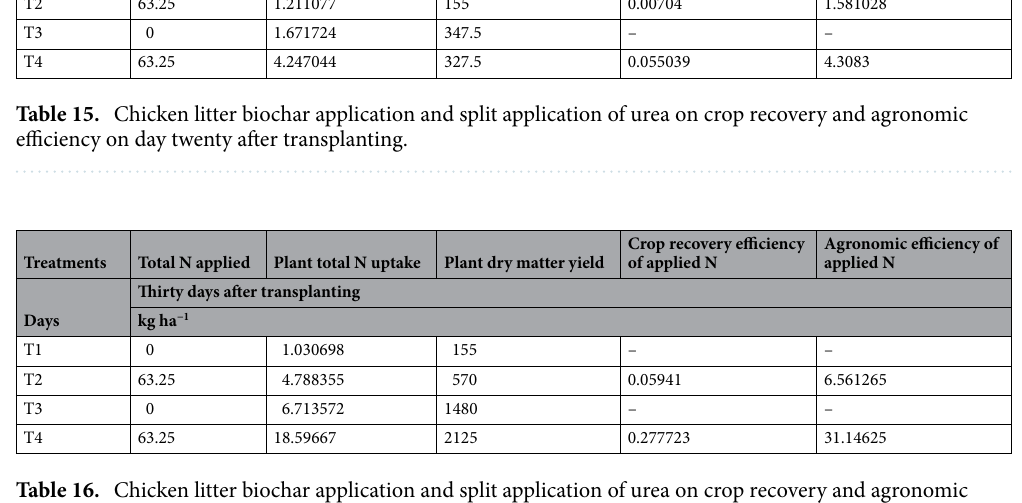
Table 16. Chicken litter biochar application and split application of urea on crop recovery and agronomic efficiency on day thirty after transplanting.